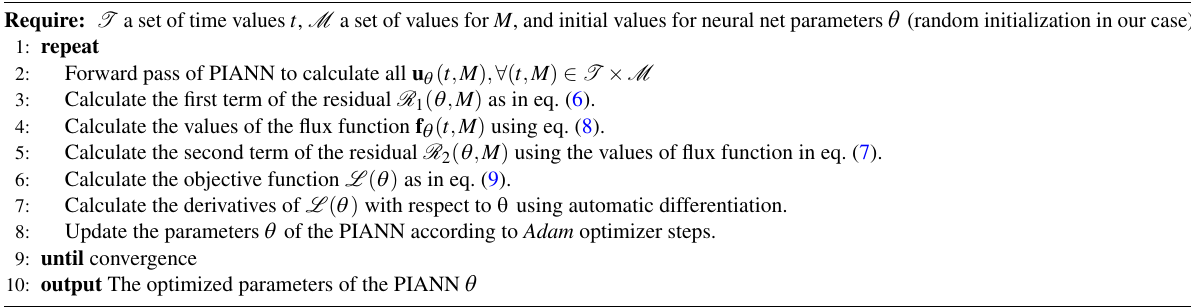
Algorithm 1 Training algorithm pseudo-code for